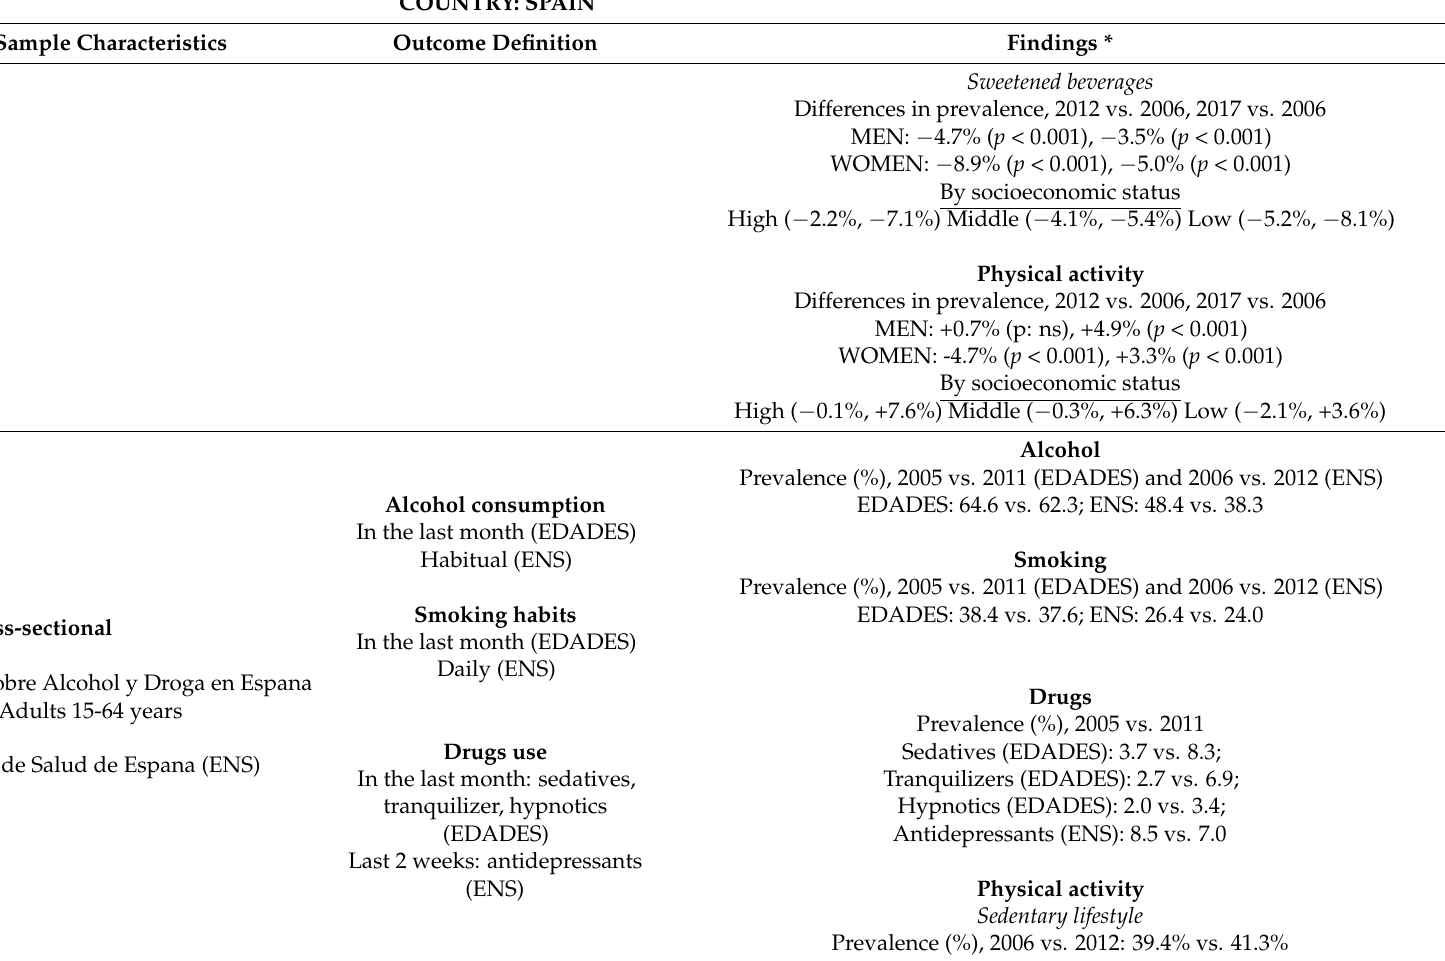
Table 1. Cont. COUNTRY: